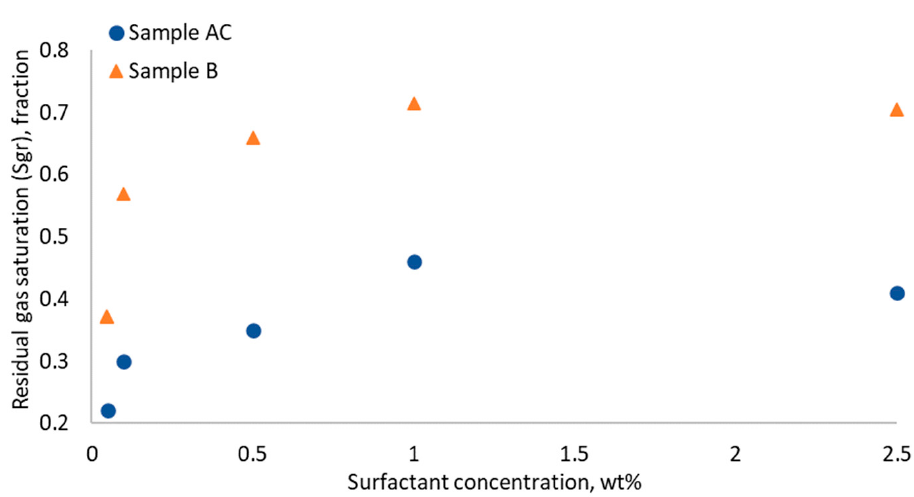
Figure 11. Initial–residual saturation curves of the B sample under SAG injection conducted with various surfactant concentrations. The solid and dashed lines show Land’s model fitting using var- ious values of the C coefficients.